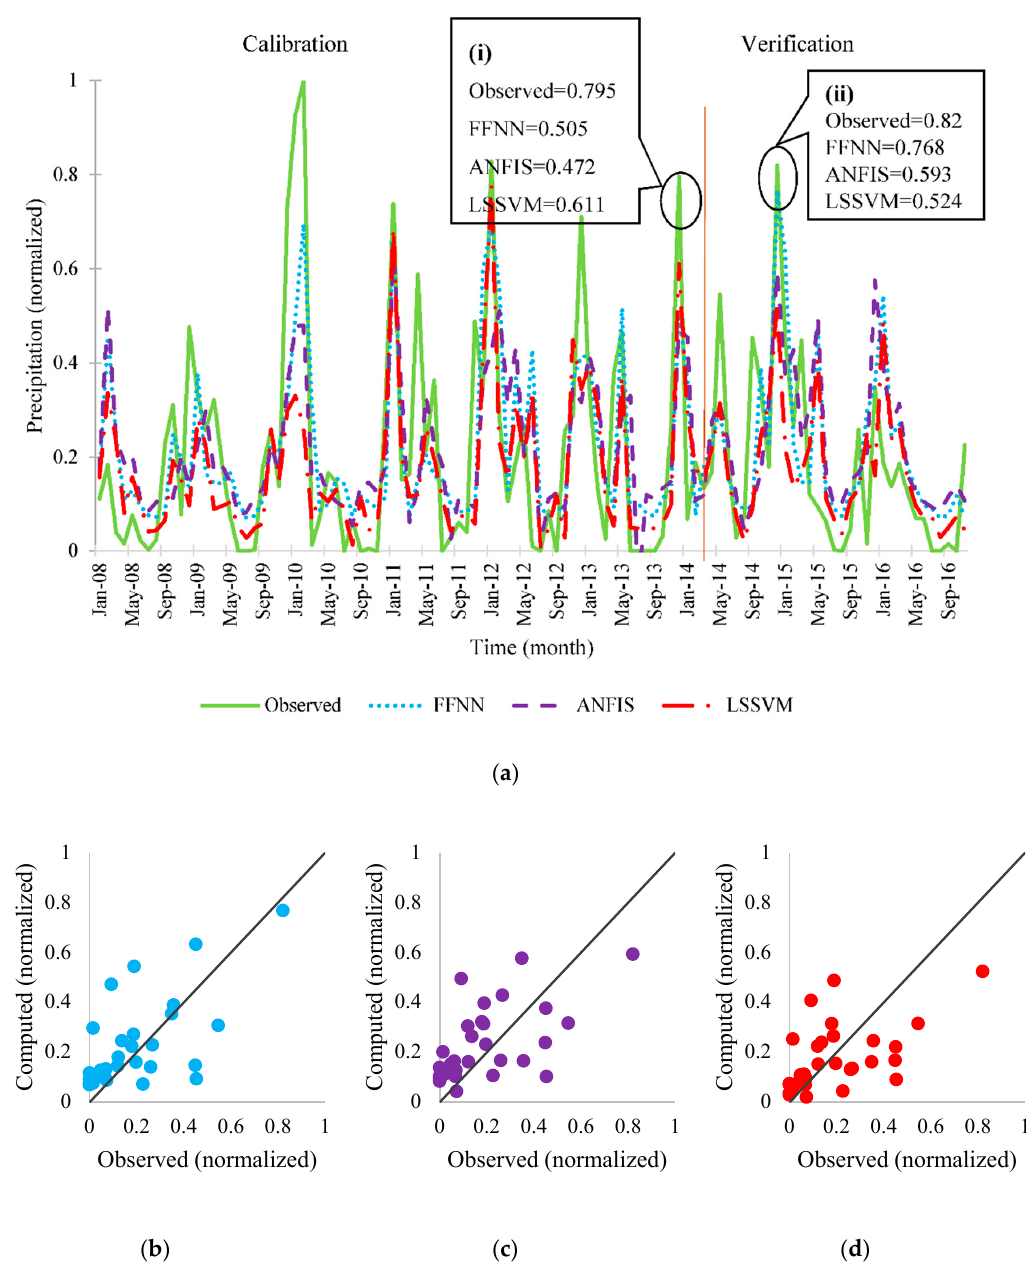
Figure 9. ( a ) Observed versus computed precipitation time series by FFNN, ANFIS and LSSVM models. Scatter plots for verification step for ( b ) FFNN; ( c ) ANFIS; ( d ) LSSVM models via scenario 1 for Ercan station.